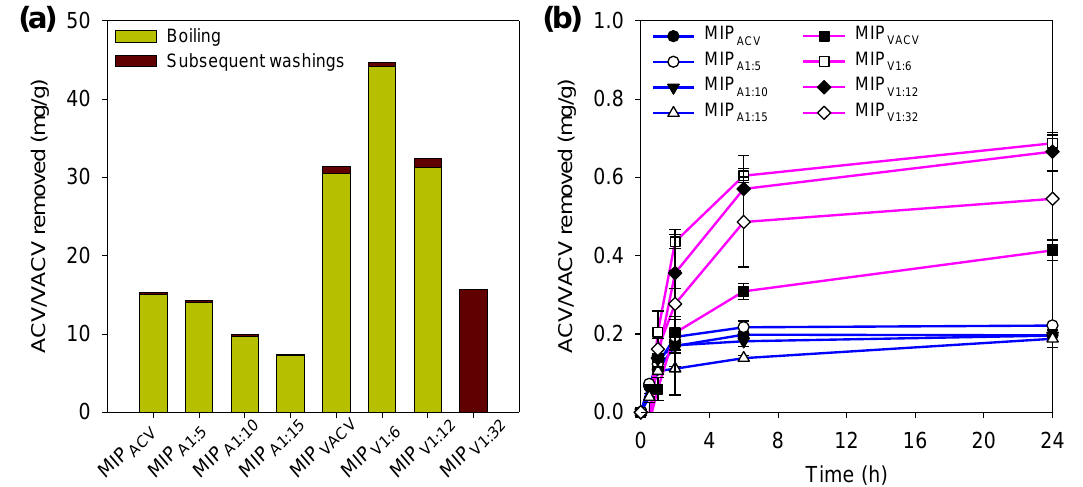
Figure 3. ( a ) Amounts of ACV and VACV removed during washing in boiling water and subsequent washings from each of the hydrogels tested (codes as in Table 1), and ( b ) release profiles of ACV and VACV from the imprinted discs that were previously boiled in water (15 min) and dried to constant weight. The drug released corresponds to that used as a template during synthesis.